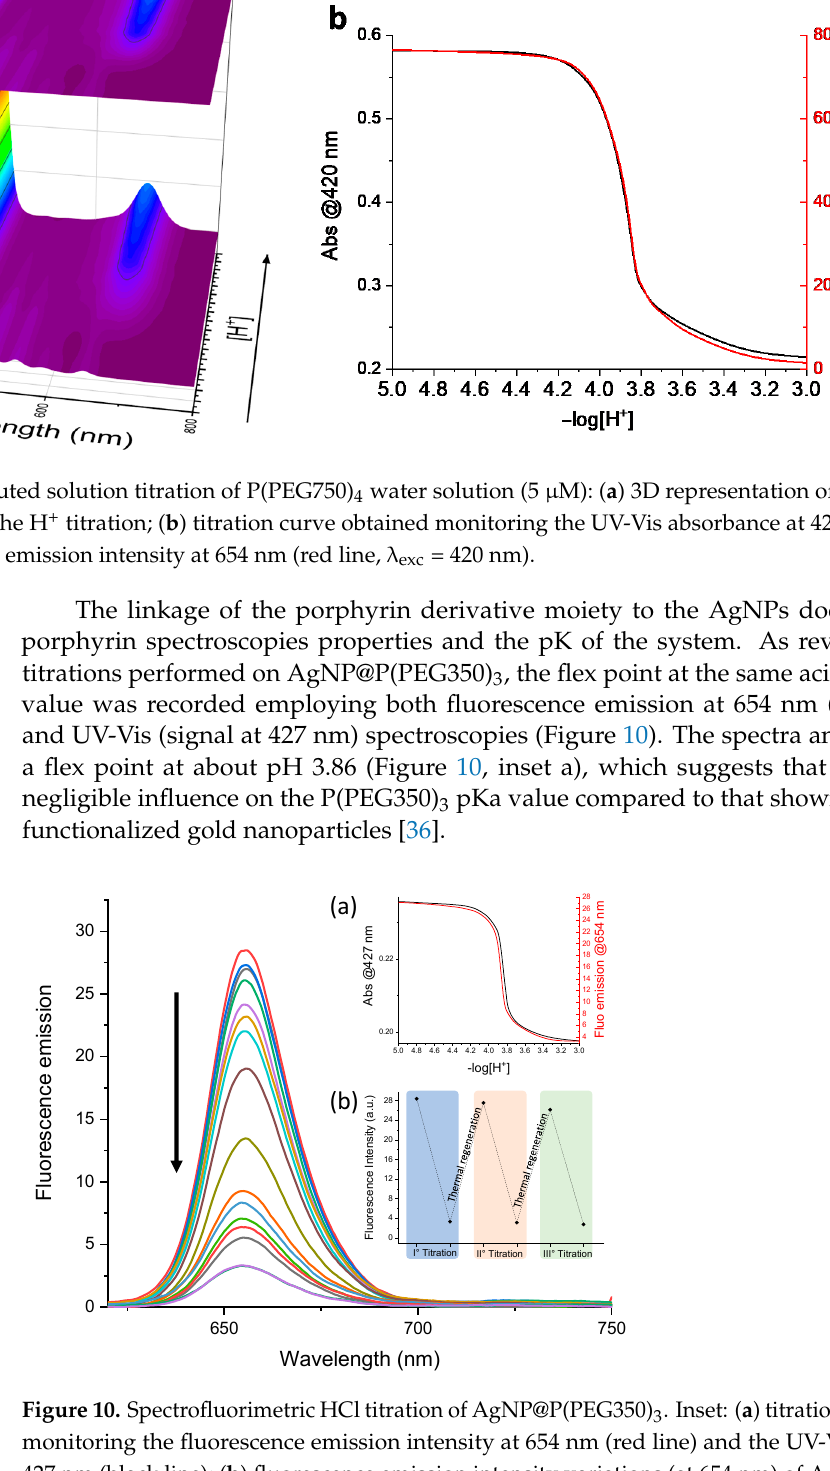
Figure 9. UV-Vis HCl-diluted solution titration of P(PEG750) 4 water solution (5 μ M): ( a ) 3D representation of the UV-Vis spectra acquired during the H + titration; ( b ) titration curve obtained monitoring the UV-Vis absorbance at 420 mn (black line) and the fluorescence emission intensity at 654 nm (red line, λ exc = 420 nm).